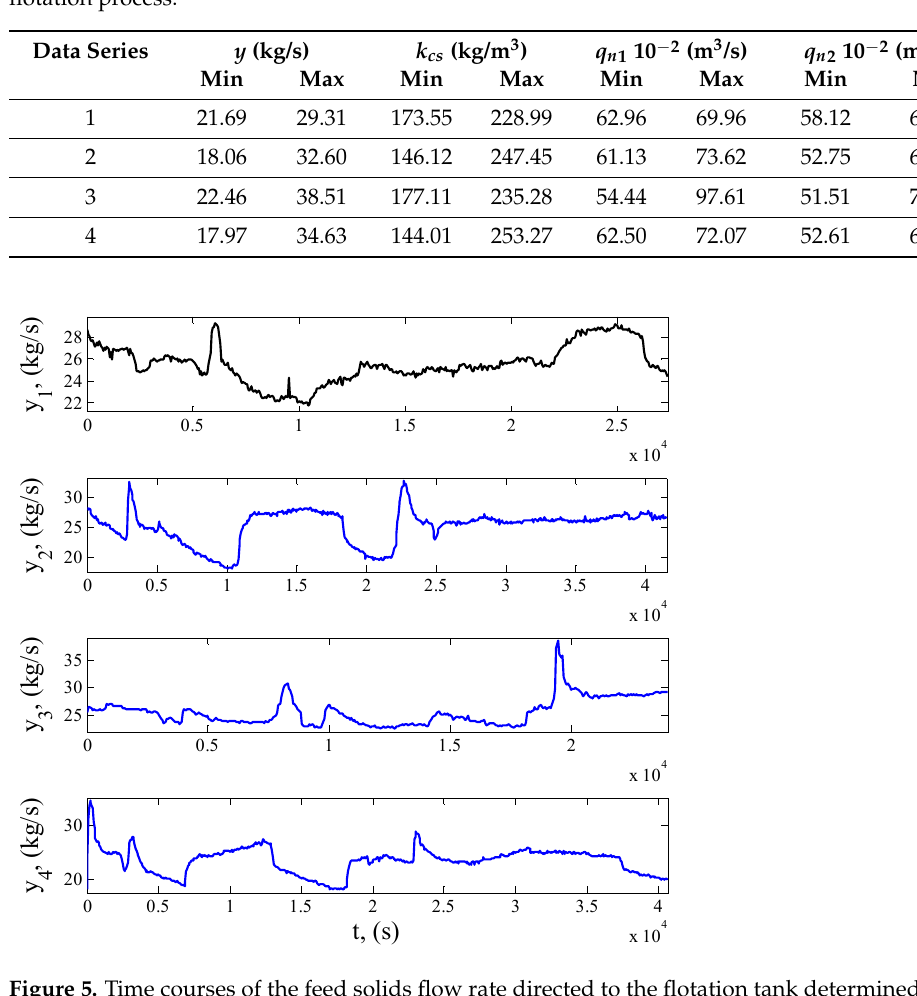
Figure 5. Time courses of the feed solids flow rate directed to the flotation tank determined on the basis of the solids concentration courses and the feed flow rate recorded at the industrial facility.